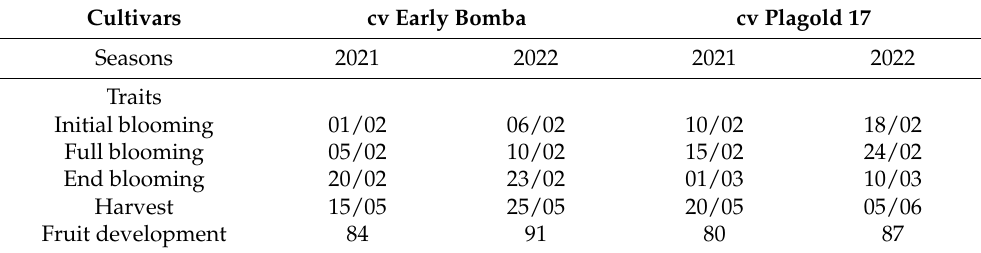
Table 2. Blooming and harvesting time for the two peach and nectarine cultivars. Bloom beginning, full bloom and bloom end dates, were determined. Data are means of two consecutive years for each peach